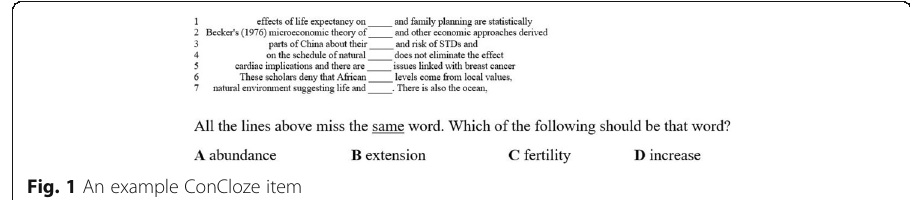
Fig. 1 An example ConCloze item